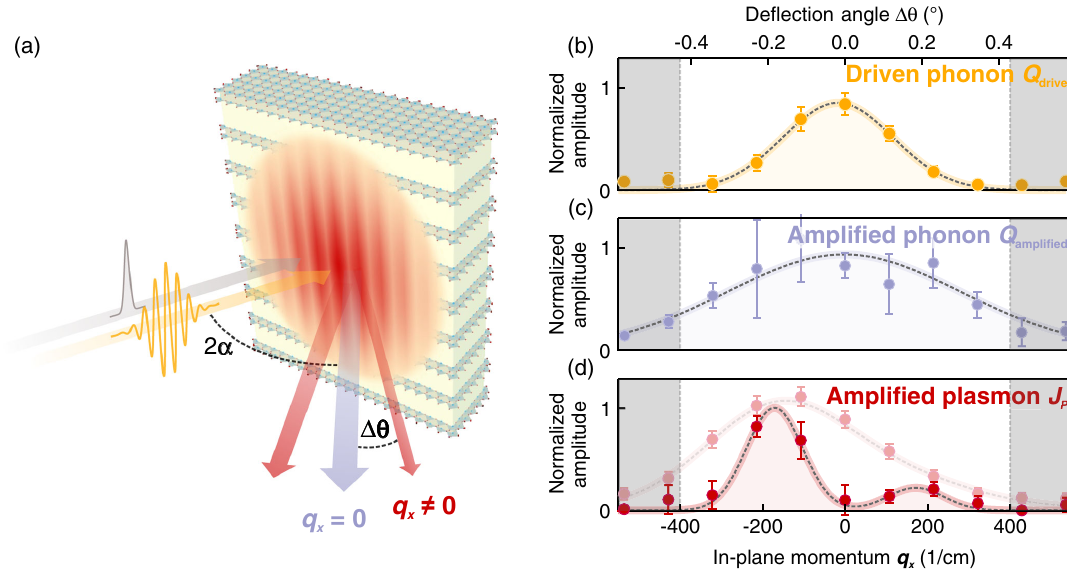
FIG. 4. (a) Schematic of the collinear geometry, where pump and probe beams are aligned collinear to excite the sample at an incidence angle α to the surface normal. The specular linear reflection at 800 nm (gray arrow) obeys Snell ’ s law and leaves the sample with the same angle α . A finite-momentum transfer, due to scattering of propagating modes, appears as a deflection Δ θ from the specular deflection (red arrows). (b) – (d) Momentum distribution of the driven phonons, amplified phonons, and amplified JPPs, measured at room temperature. Panel (d) shows the raw data (light red) together with deconvolved data (dark red), using the measured Gaussian profile of the q ¼ 0 pump electric field induced SH response. The gray shaded areas denote the maximum accessible momentum of the experiment. For all the raw data in (b) – (d), error bars represent the standard deviation σ of the amplitudes extracted from numerical fits to the time-resolved second-harmonic intensity changes. The error bars of the deconvolved data (d) are determined from the deviation of the least squares fit, used in the deconvolution, to the raw data points (see Supplemental Material [24]). The data were recorded at room temperature with a peak field strength of ∼ 5 MV =